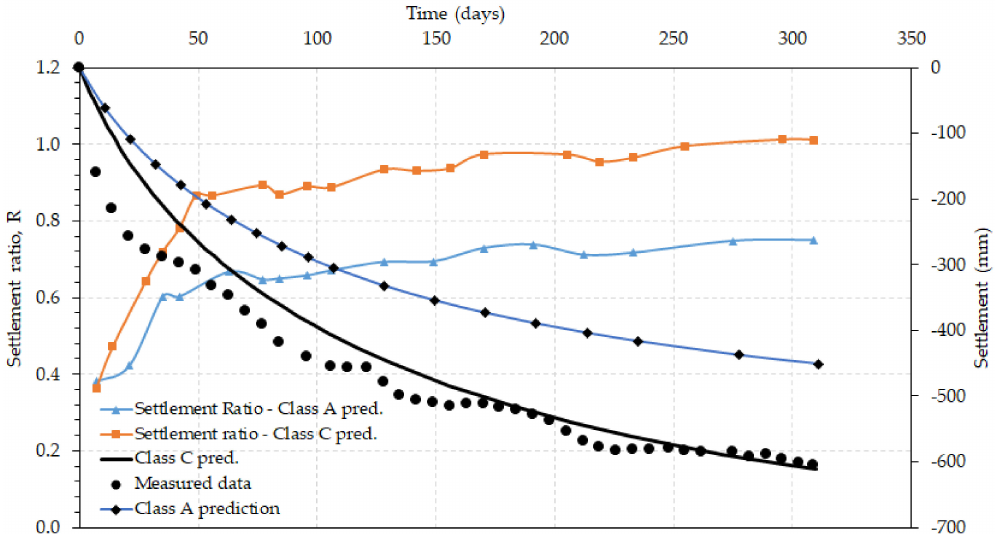
Figure 5. Settlement ratio and predicted settlements vs. time for Karakore clay.